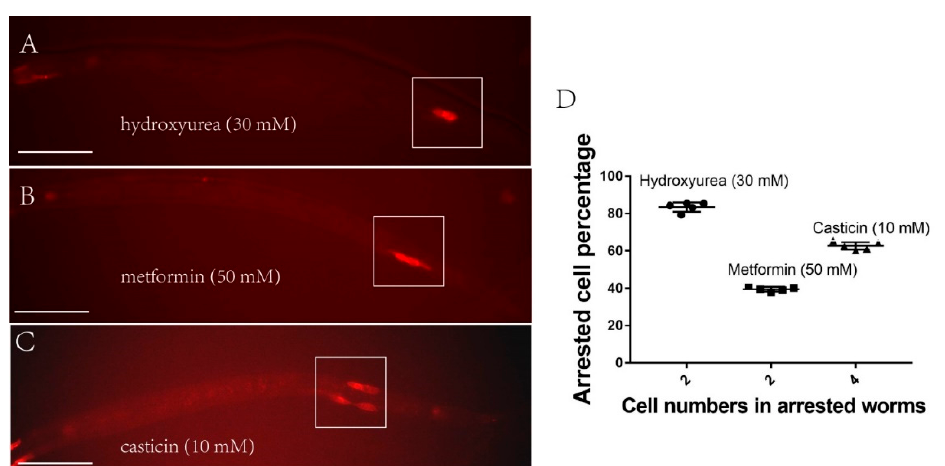
Figure 4. Metformin blocks Q-cell division at the G1/S stage of the cell cycle. Casticin is a G0/G1 blocker and hydroxyurea is a G1/S blocker. ( A ) Hydroxyurea-treated (30 mM) L1-arrested worms after feeding cannot go through the next cell cycle, so only two Q cells are apparent. ( B ) About 40% of metformin-treated (50 mM) L1-arrested worms after feeding cannot go through the next cell cycle, so only two Q cells are apparent. Metformin cannot fully suppress the Q-cell divisions in L1-arrested worms and about 60% of these worms can bypass the function of metformin and go through all the cell divisions (presenting all six Q-cell decedents). ( C ) Most of the casticin-treated (10 mM) L1-arrested worms after feeding can go through one more cell cycle, so four Q cells are apparent. ( D ) Metformin and hydroxyurea hold the Q cells at the G1/S phase and casticin holds the Q cells at the G0/G1 phase. Data are the average of five independent experiments. The sample size in each experiment is larger than 80 worms. Error bars: standard deviation (SD). Scale bars: 50 μ m.